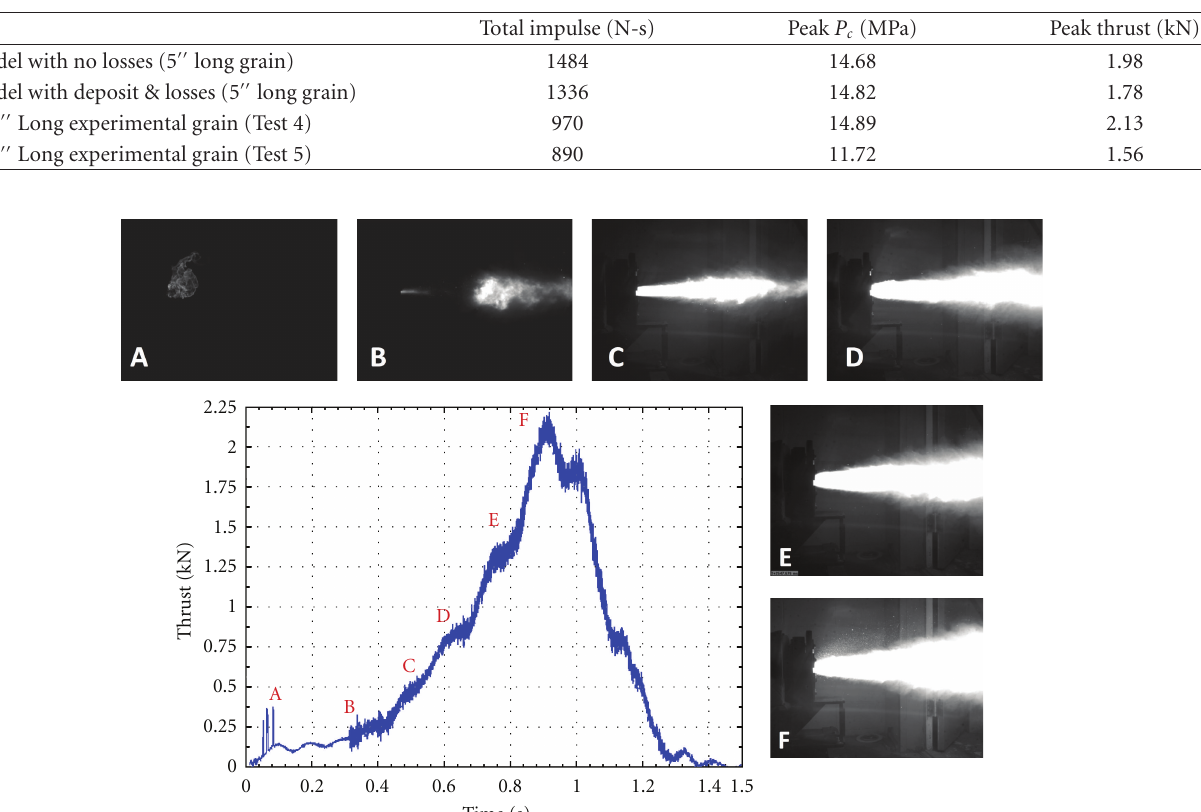
Table 5: Comparison of modeling and experimental results for 5 (cid:4)(cid:4) long grains.